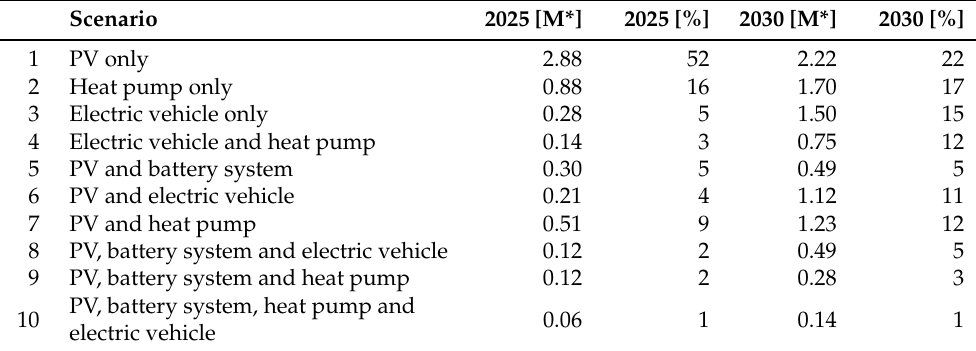
Table 1. Different combinations of microsystems and their weighting according to the Grid Develop- ment Plan in *million units and percent.